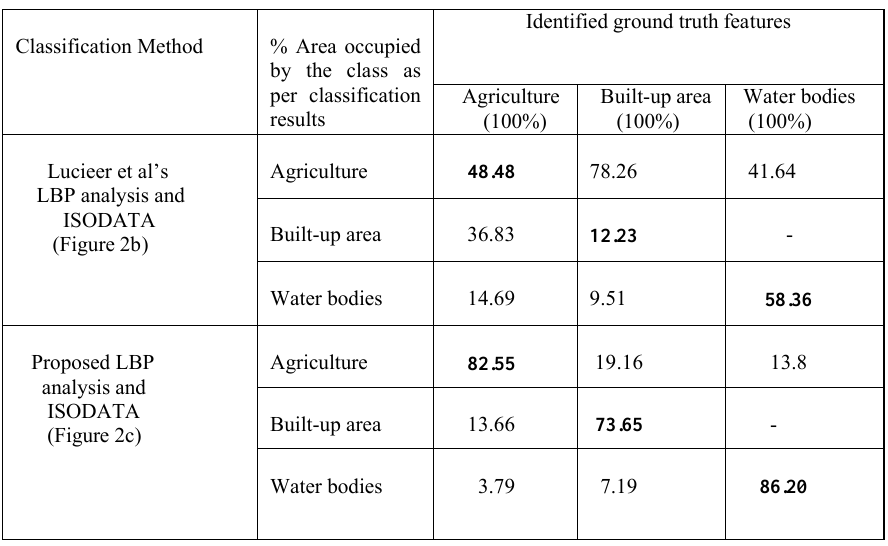
Table 1: The comparative success rate for classifying the features obtained by applying “Lucieer et al’s LBP analysis and ISODATA” and “Proposed LBP analysis and ISODATA” separately on RISAT-II X-Band image. The column of the Table represents the percentage (%) of area occupied by the features according to the classification results when there is a unique feature as per the ground truth.